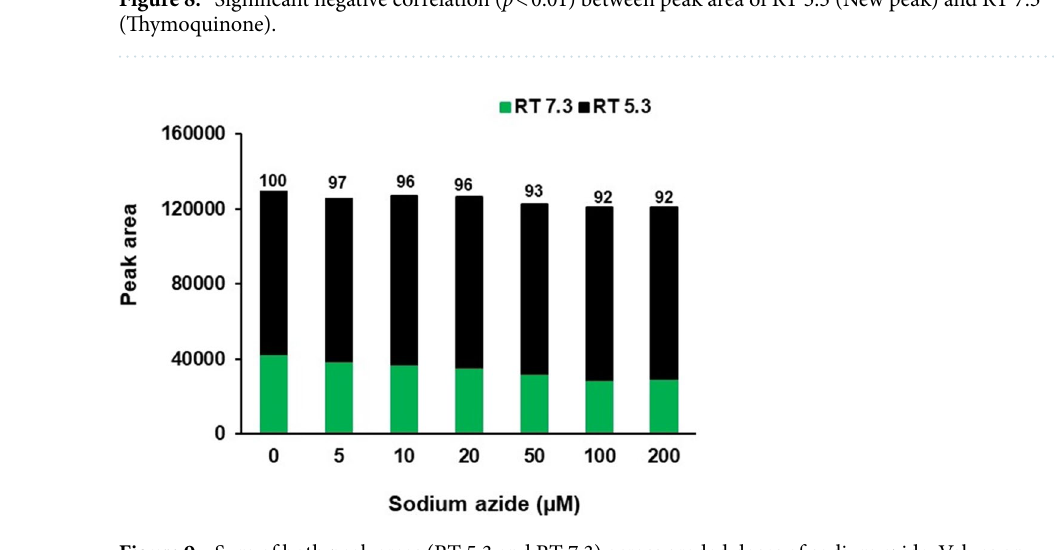
Figure 9. Sum of both peak areas (RT 5.3 and RT 7.3) across graded doses of sodium azide. Values on histograms denote comparison (%) with Control (100) and are not significantly different from each